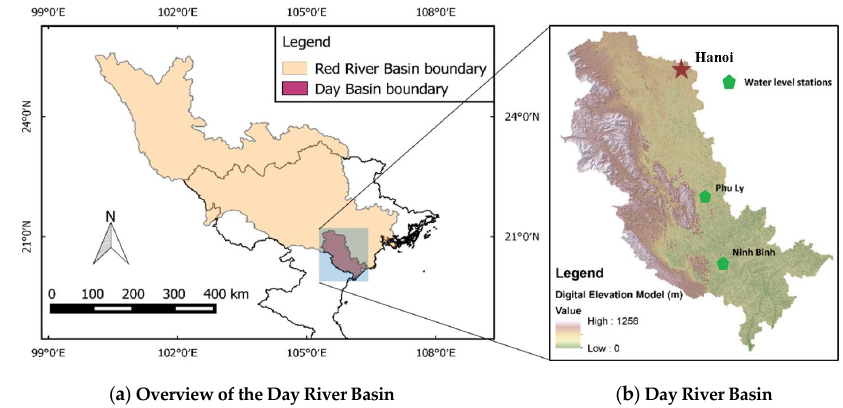
Figure 1. ( a ) Geographical location of the Day Basin as part of the Red River delta in Northern Vietnam. ( b ) Digital Elevation Model from Shuttle Radar Topography Mission (SRTM) for the Day River Basin and the location of two water level stations.